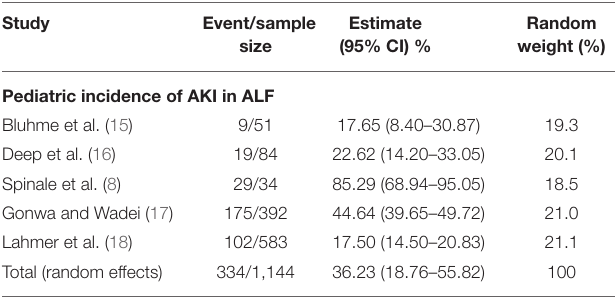
TABLE 2 | Meta-analysis of proportion of AKI among ALF patients across different studies.